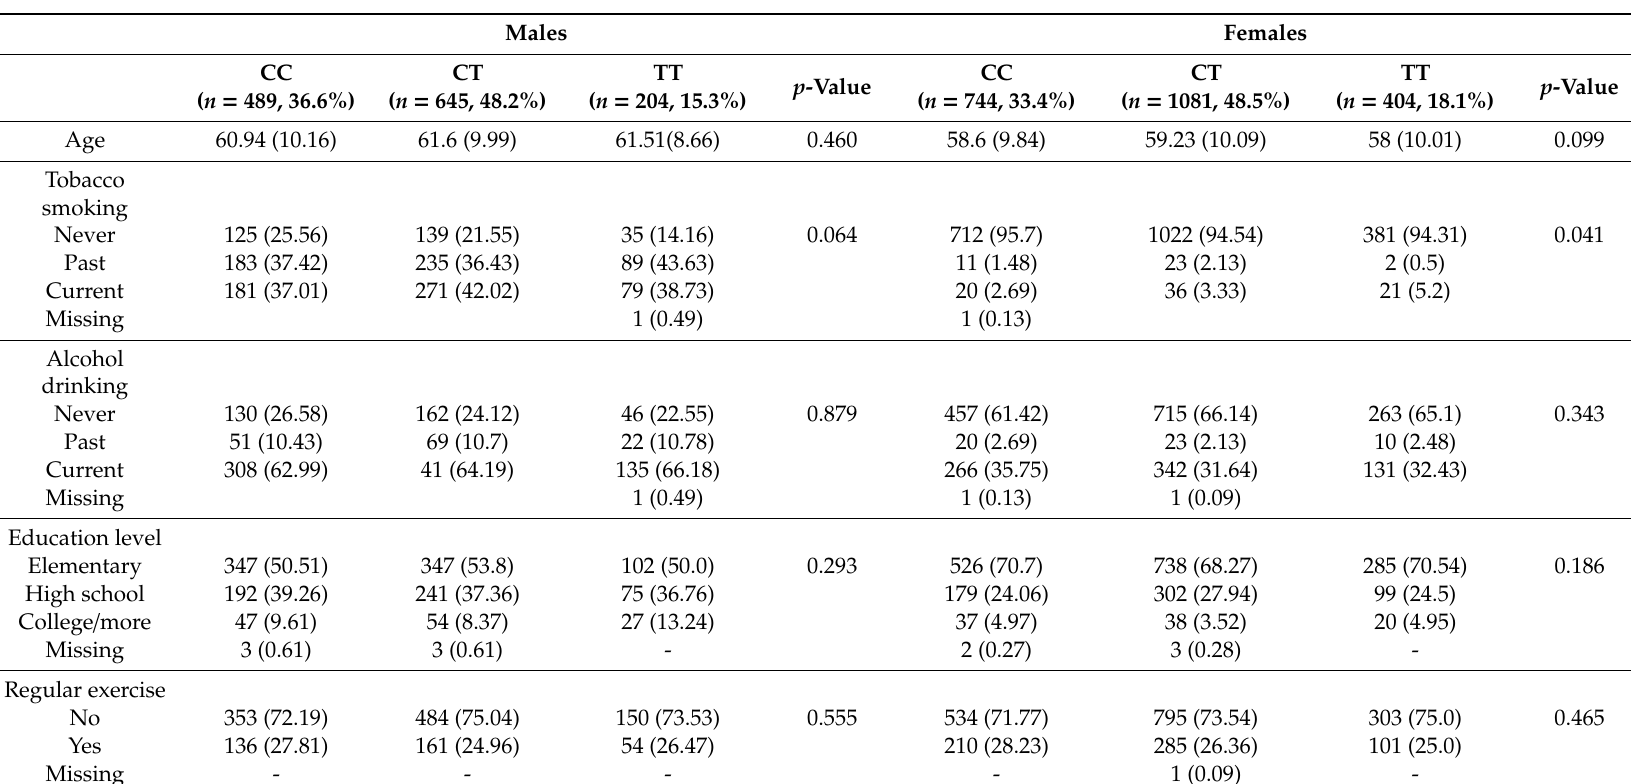
Table 1. Descriptive data of the study subjects taking into account the TAS2R38 rs10246939 genotype and